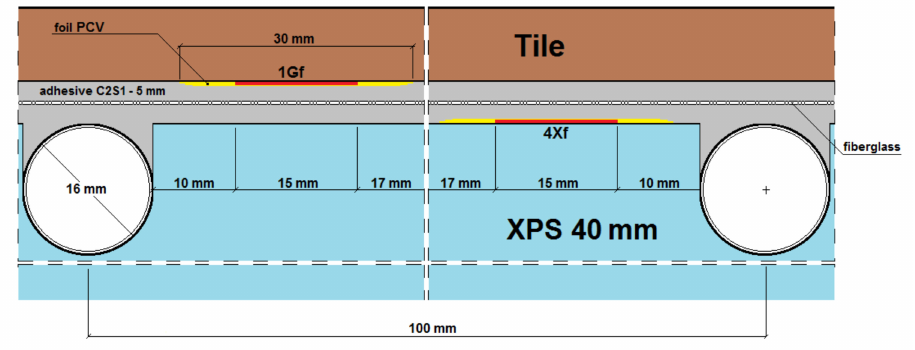
Figure 9. Vertical section III–III of the research model with C2S1 adhesive, without lamellas.